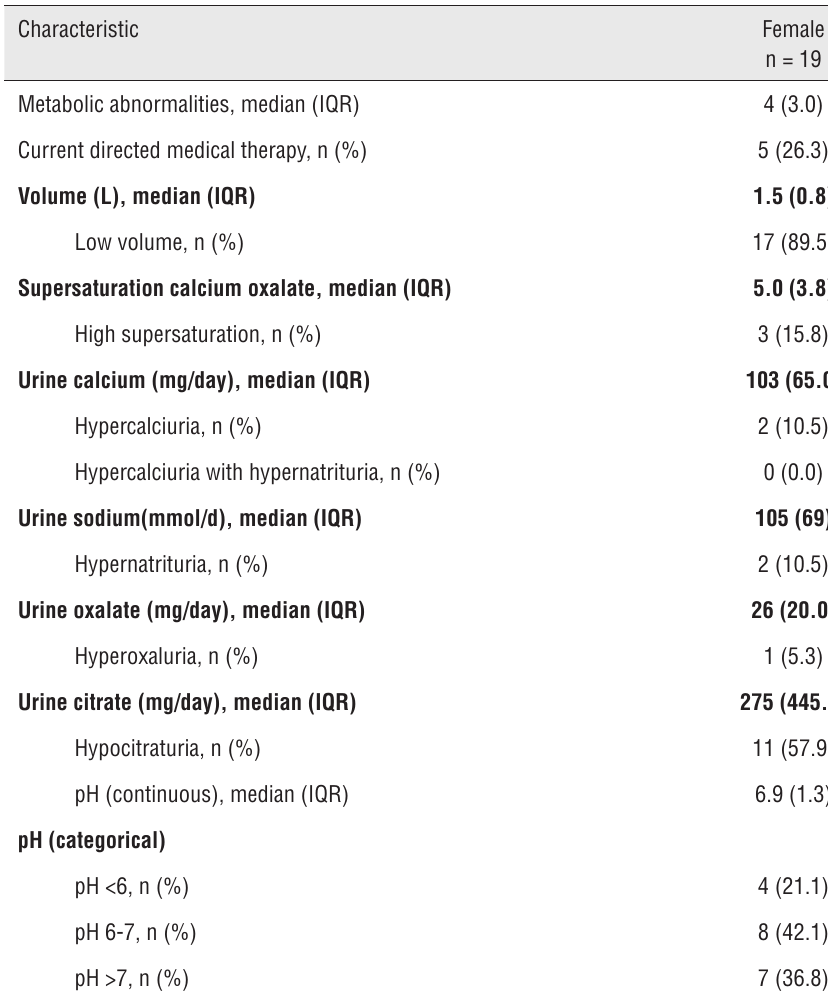
Table 3 - Urinary metabolic parameters by